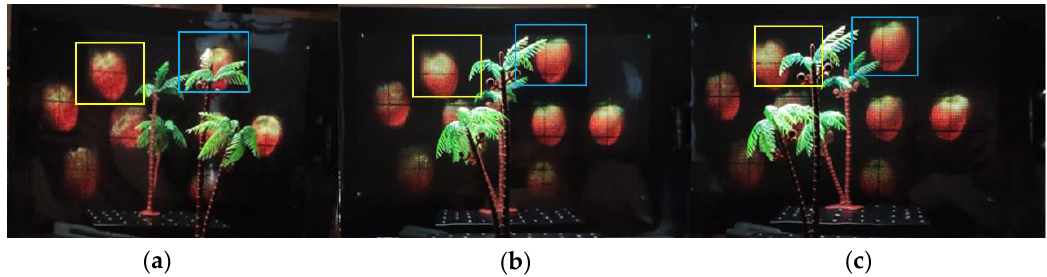
Figure 5. Different views of the 3D image reconstructed by the proposed prototype. ( a ) Left view, ( b ) center view, and ( c ) right view.